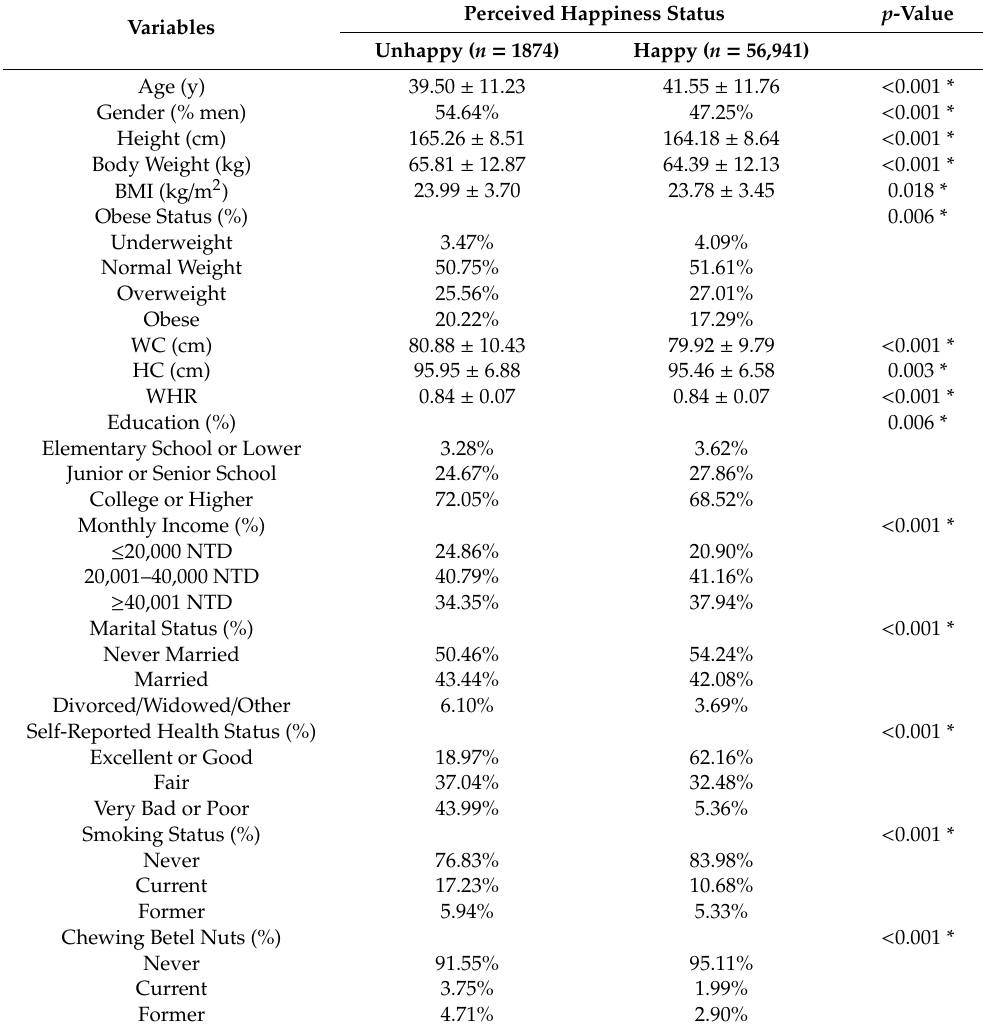
Table 1. Demographic characteristics and anthropometric indices of the study